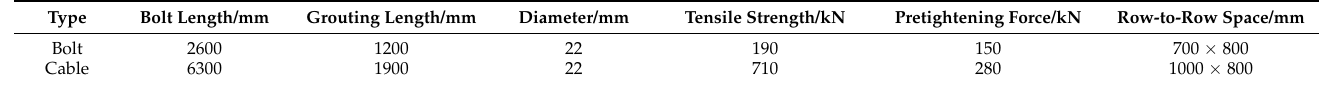
Table 3. Support structure parameters.